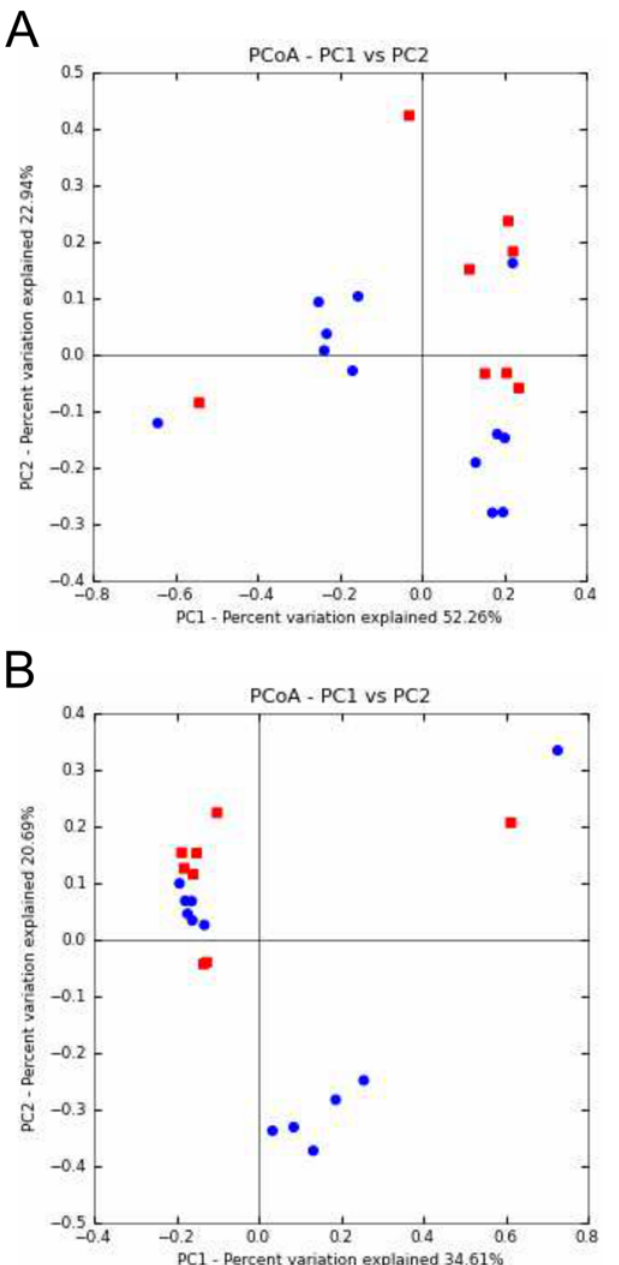
Fig 4. Principal coordinates analysis (PCoA) of CF sputum samples according to ivacaftor treatment and microbial community composition and abundance. A) PCoA of microbial community structures using weighted and normalized UniFrac phylogenetic distances. A clustering of 6 of the 8 BT samples (before ivacaftor treatment; red squares) was observed. Conversely, AT samples (after ivacaftor treatment; blue circles) appeared scattered on the graph. PC1 and PC2 represented 75.2% of the variability. B) PCoA of microbial community structures using Bray Curtis non-phylogenetic distances. Seven of the 8 BT samples (red squares) were clustered. PC1 and PC2 represented 55.3% of the variability.